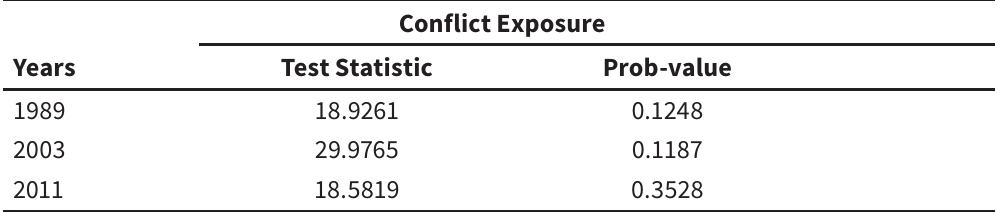
Overidentification Tests for the IPW